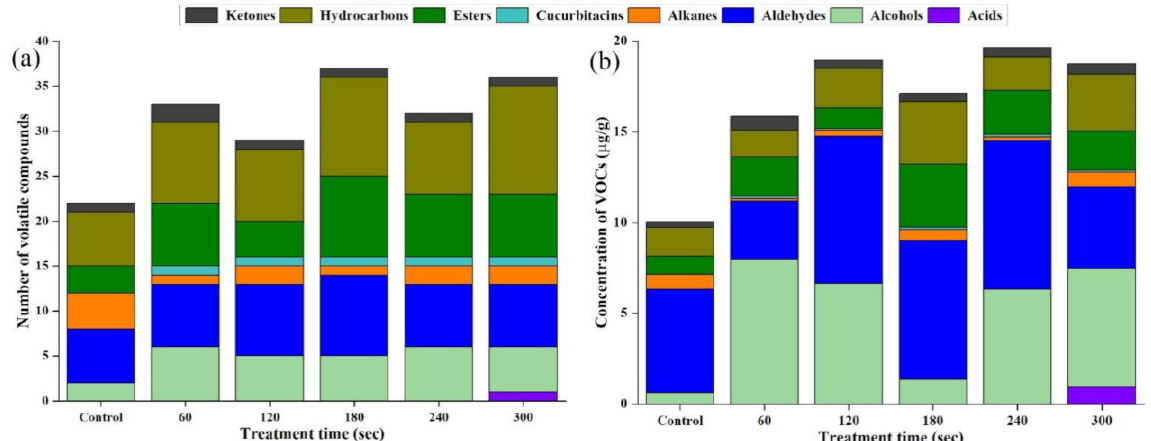
Figure 5. ( a ) The number of volatile compounds identified in the HVCP-treated EWP using HS-GC- IMS. ( b ) The concentrations of volatile compounds classes identified in the HVCP treated EWP using